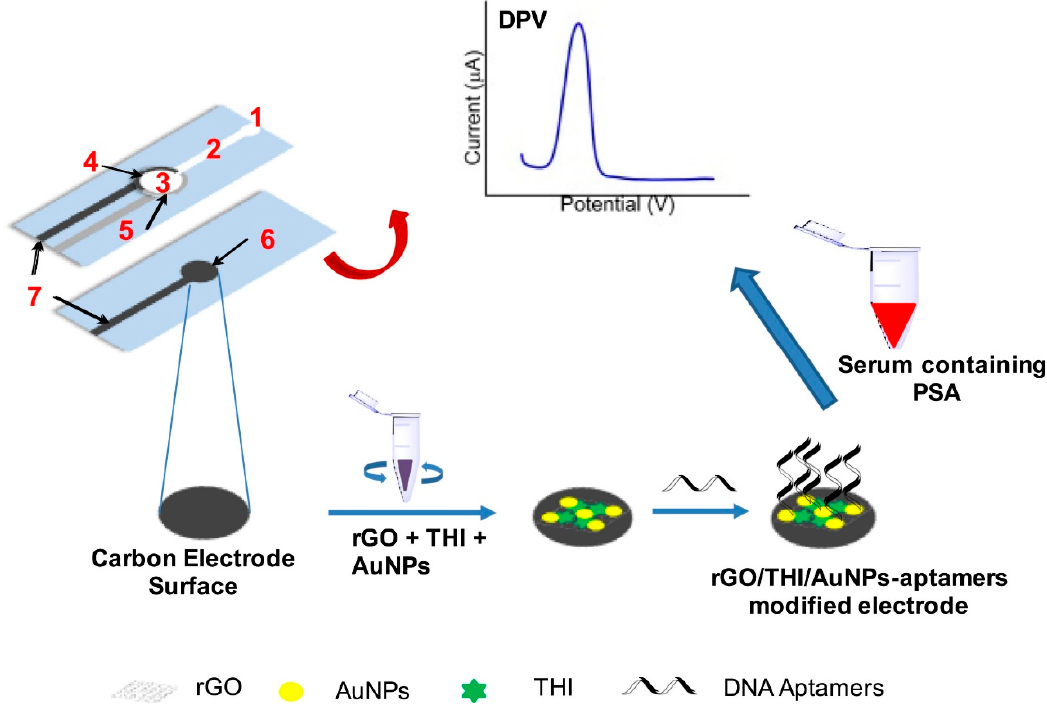
Figure 4. Schematic representation of microfluidic paper-based electrochemical aptasensor for the specific detection of prostate-specific antigen (PSA) in clinical samples. Reproduced with the permission. [224] . Copyright 2018, Elsevier.